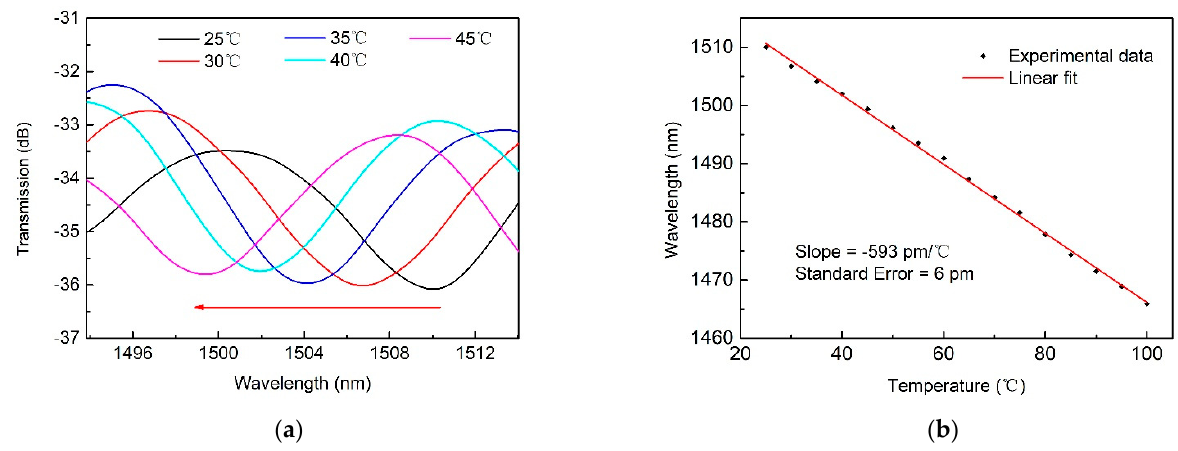
Figure 5. ( a ) Transmission spectra for the WGM resonator under different ambient temperatures for the case of a 20 μ m microsphere. ( b ) Linear fit of the measured temperature response.